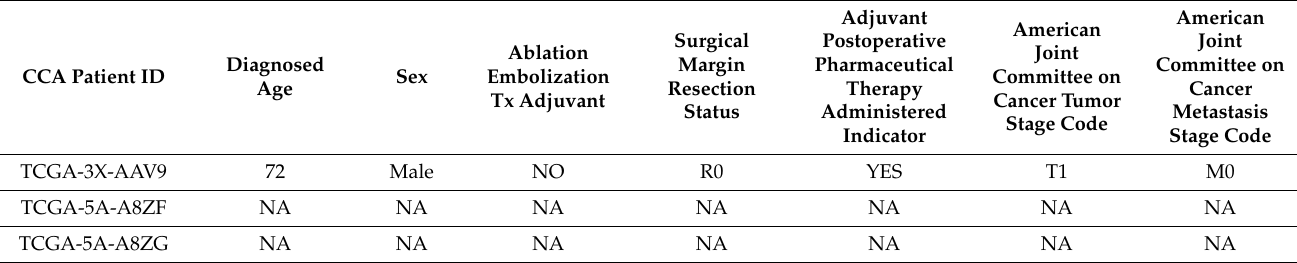
Table 3. Clinical characteristics of 51 CCA